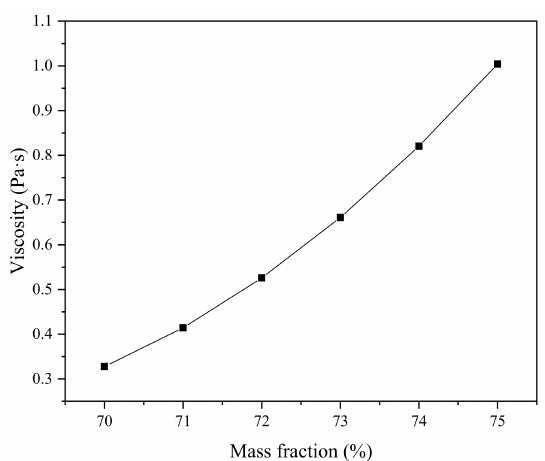
Figure 20. Fitting curve of plastic